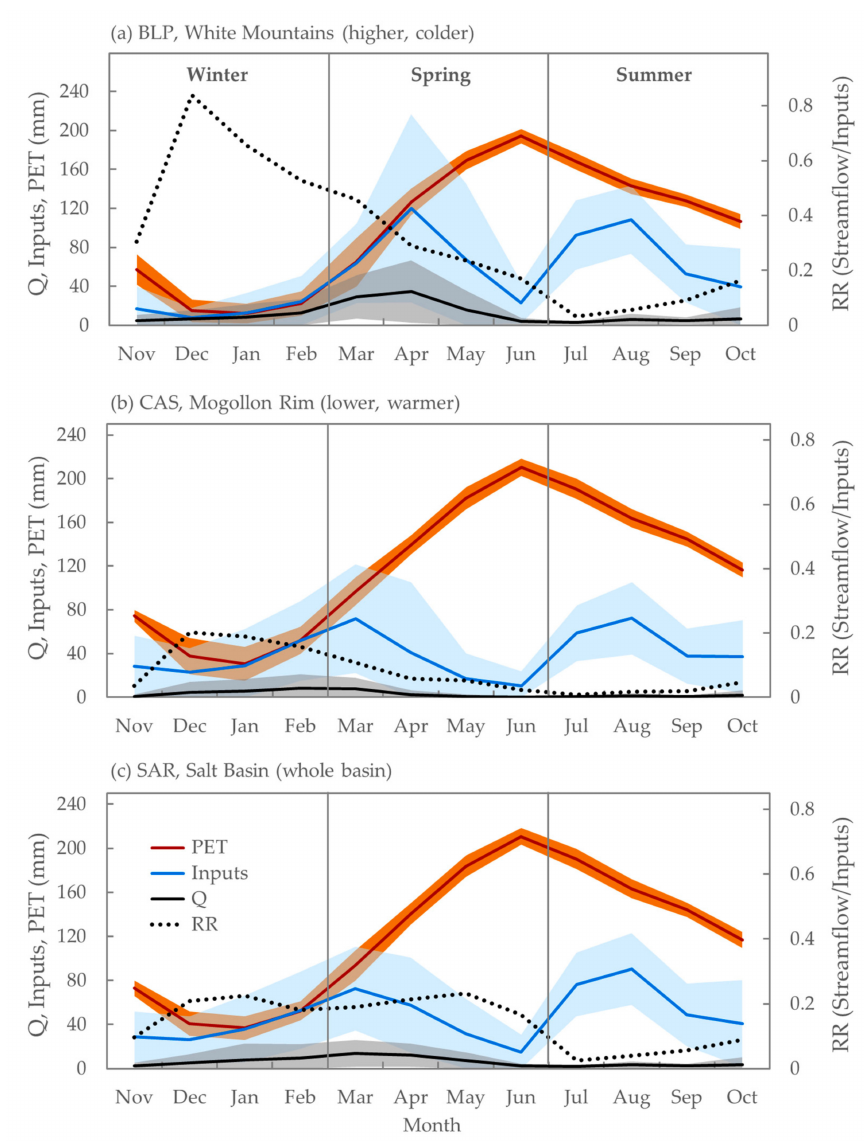
Figure 4. Plots of mean (lines) and standard deviation (shaded areas) of area-normalized streamflow (Q), potential evapotranspiration (PET), and hydrological inputs (sum of snowmelt, rain-on-snow, and rainfall) for Black River Point of Pines (BLP, White Mountains) ( a ), Carrizo Creek (CAS, Mogollon Rim) ( b ), and Salt River (SAR, whole basin) ( c ) from 1968–2011. RR is mean runoff ratios (Q/hydrological inputs) shown as dotted black